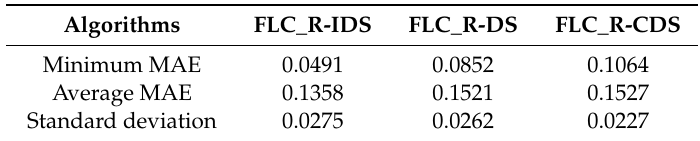
Figure 9. Comparison of the path tracking best performances of the proposed FLC_R-IDS, FLC_R-DS and the FLC_R-CDS methods in test environment 1. Table 4. Comparison of 30 controllers and their MAE values of various existing models in test environment 1.